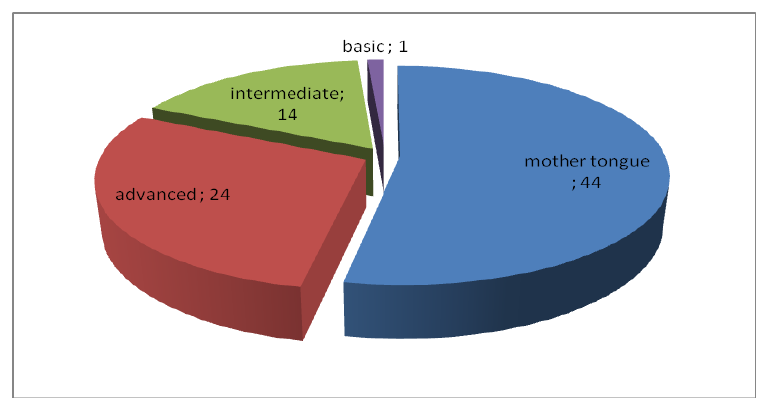
Figure 1 . English proficiency level ( N = 83).